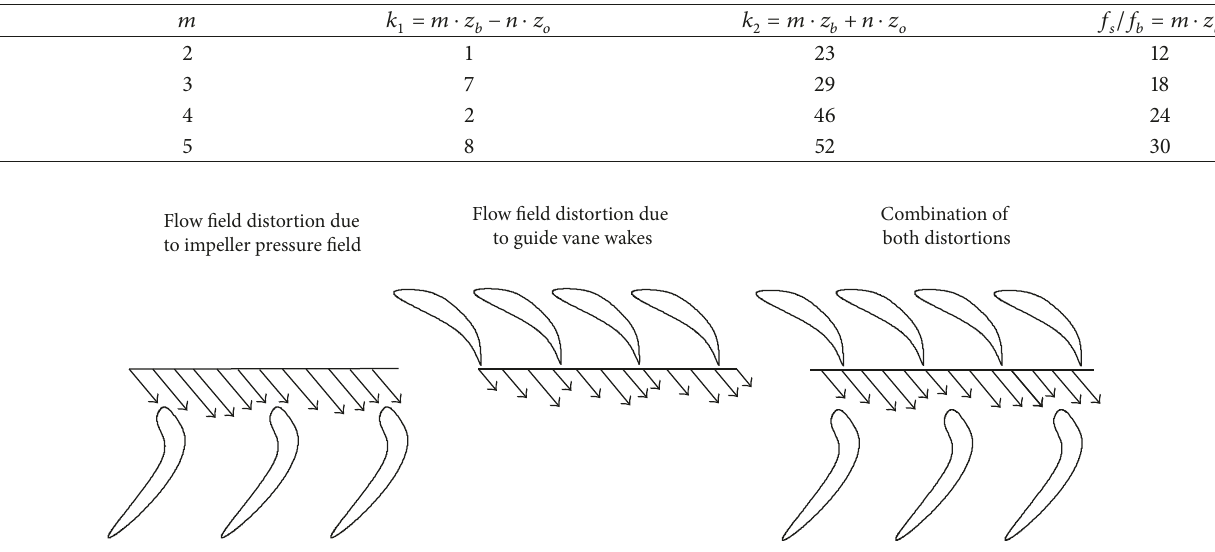
Table 3: Expected rotor-stator diametrical modes.